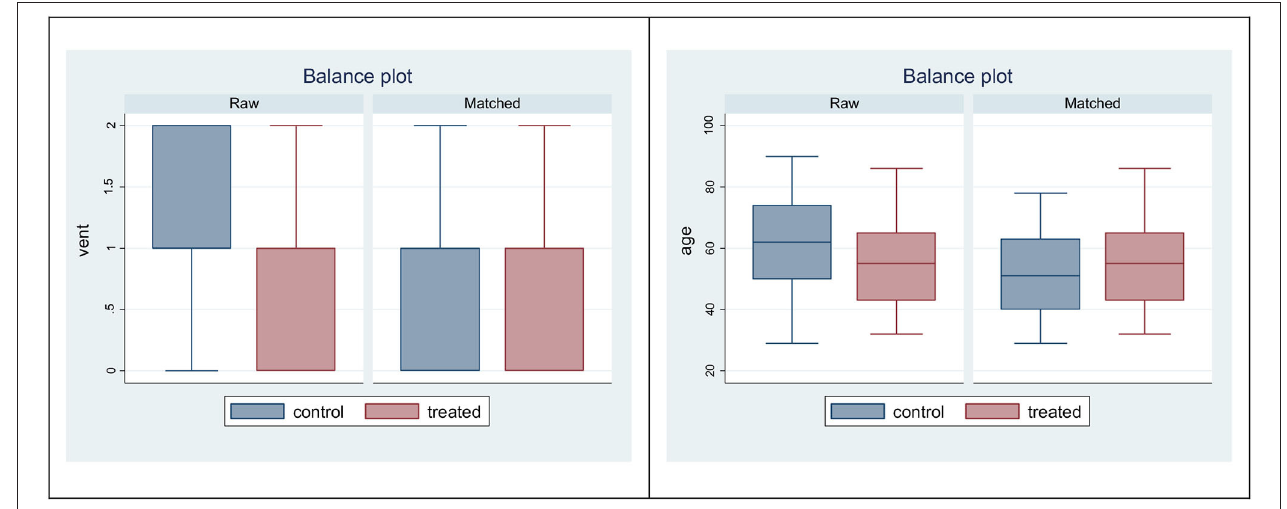
FIGURE 3 | Box plots to check for balance in propensity-score matched sample: variables vent (left) and age (right).